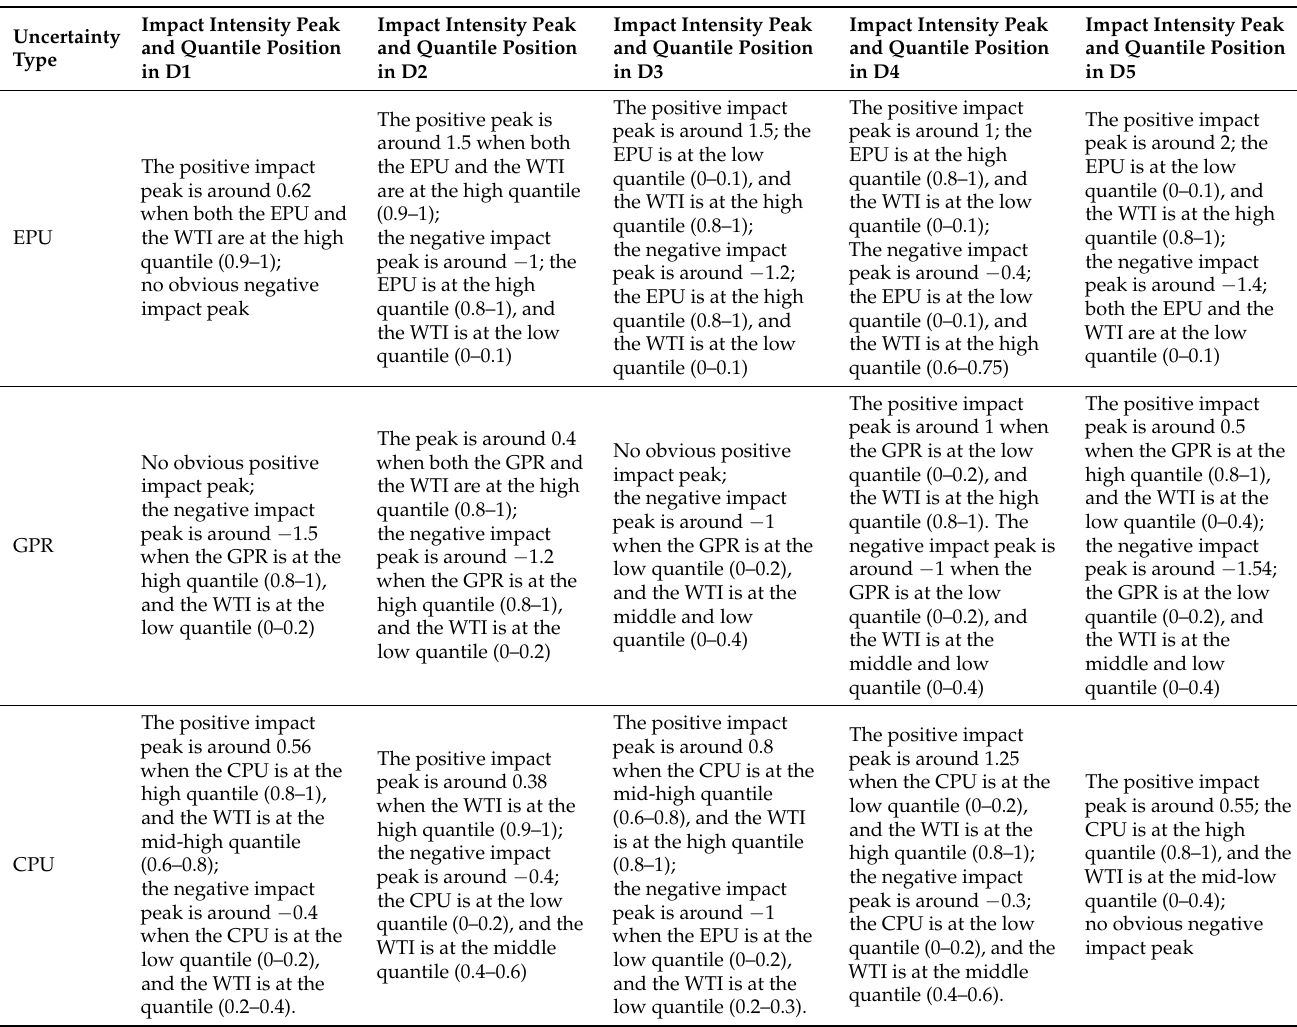
Table 7. Comparison of the impact intensities of three uncertainty indexes on crude oil price under different time